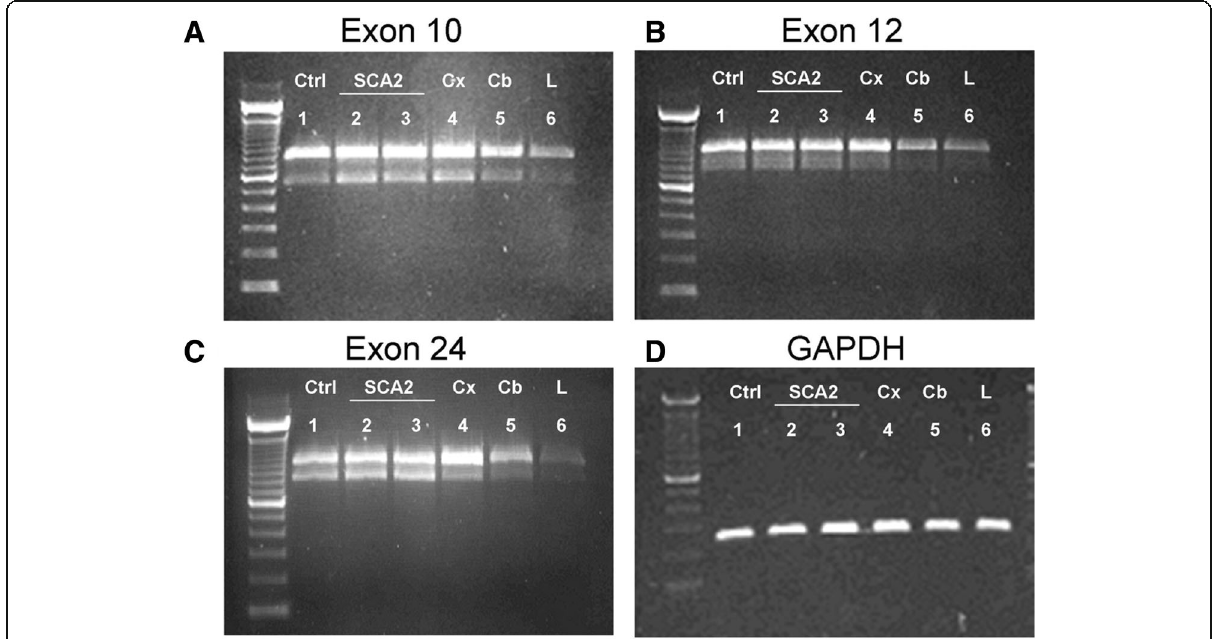
Fig. 5 The presence of CAG repeat expansion does not abolish the appearance of splice variants. Lanes: 1-normal human fibroblasts (Ctrl); 2-SCA2 fibroblasts with 41 CAG repeats; 3-SCA2 fibroblasts with 38 CAG repeats. The three lines of fibroblasts presented splicing in exon 10 ( a ), exon 12 b and exon 24 ( c ). RNA loading was controlled in an additional gel with detection of GAPDH mRNA RT-PCR products ( d ). Ataxin-2 mRNA and splice variants in mouse cerebral cortex (lane 4), cerebellum (lane 5), liver (lane 6) showed the same exon pattern as